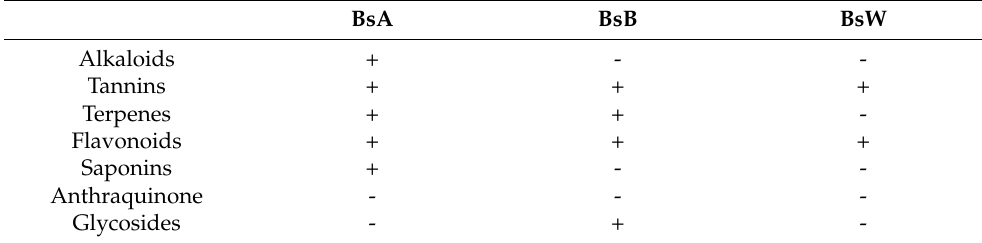
Table 2. Major phytochemical classes detected in B. saxatilis different extracts.